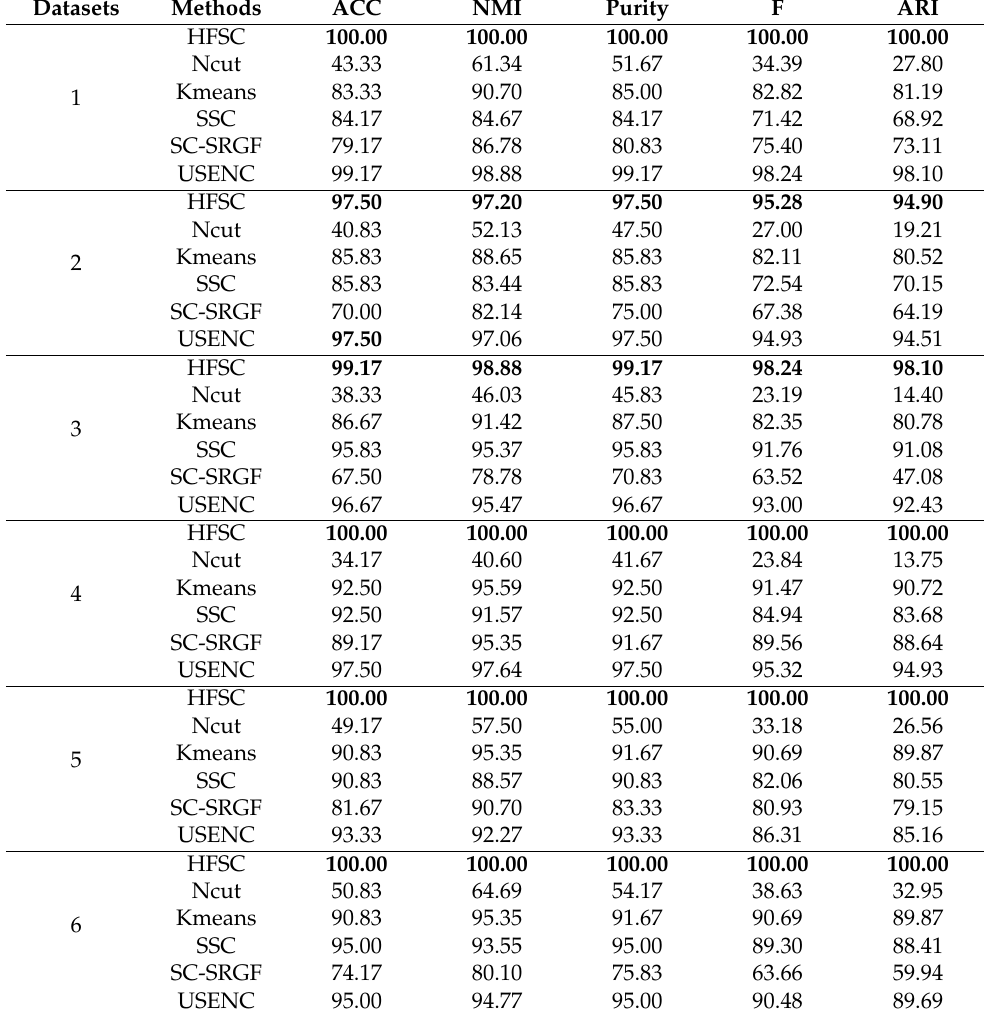
Table 2. The clustering performances of the proposed approach and the comparison methods for the simulated datasets (1 ∼ 6). The bold denotes the best